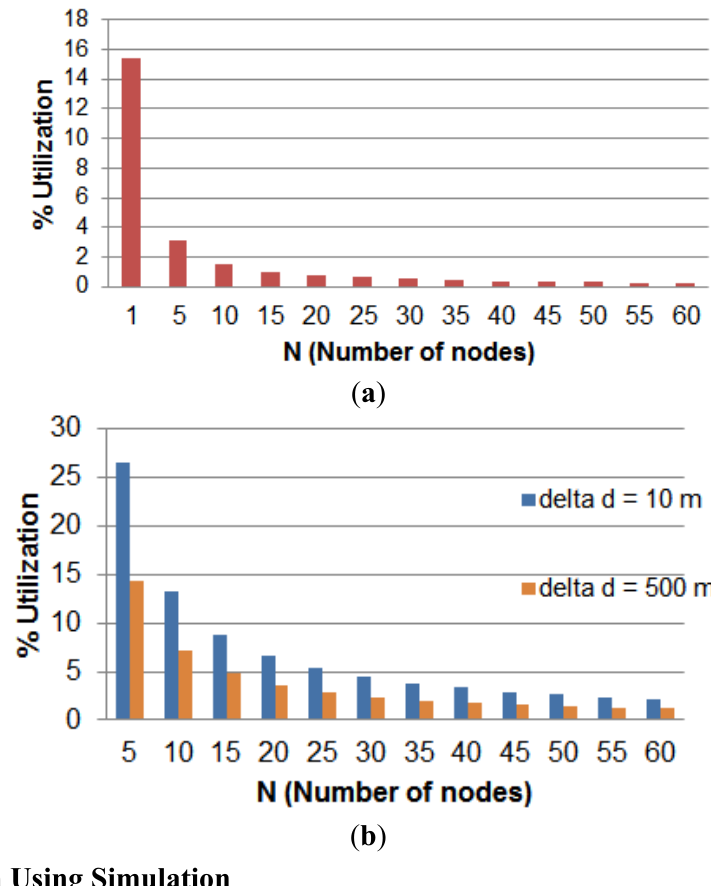
Figure 5. ( a ) Node memory utilization ( T = 30 h, Δ d = 10 m); ( b ) Node memory utilization (When N > 1) for T = 50